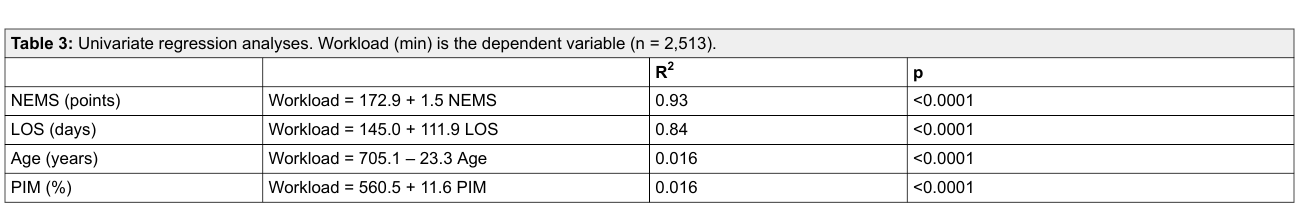
Table 3: Univariate regression analyses. Workload (min) is the dependent variable (n = 2,513).